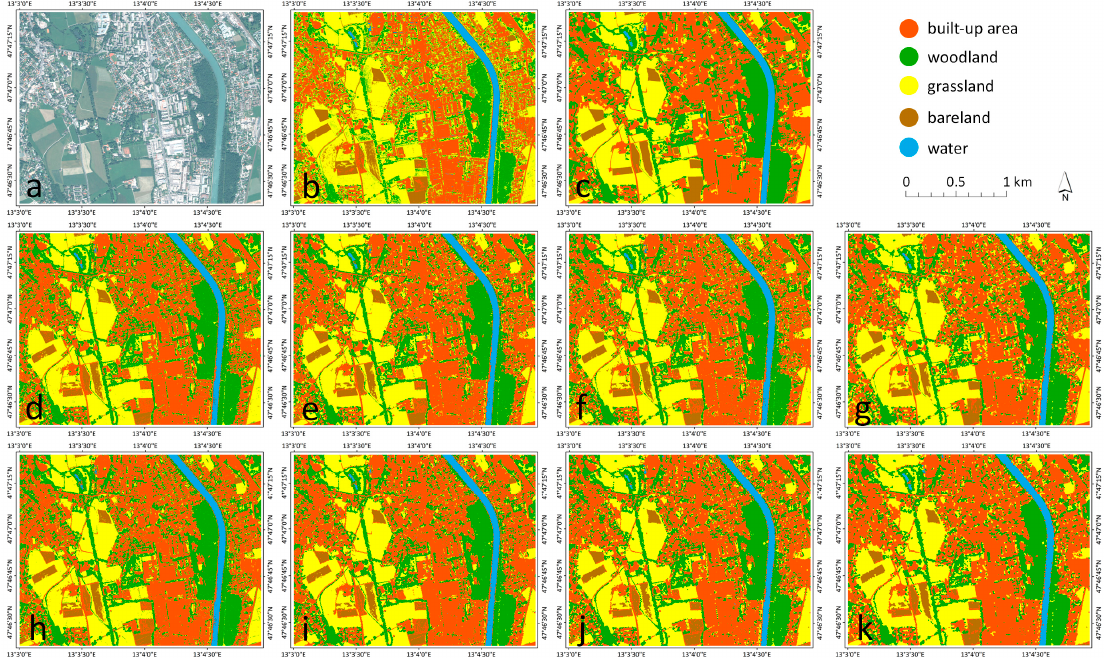
Figure 7. Random forest (RF) classification results for T2: ( a ) original QuickBird RGB image, ( b ) pixel-based classification, ( c ) multiresolution segmentation classification, ( d – g ) SLIC superpixels classification of 5 × 5, 10 × 10, 15 × 15 and 20 × 20 pixels initial size of superpixels and ( h – k ) SLICO superpixels classification of 5 × 5, 10 × 10, 15 × 15 and 20 × 20 pixels initial size of superpixels.